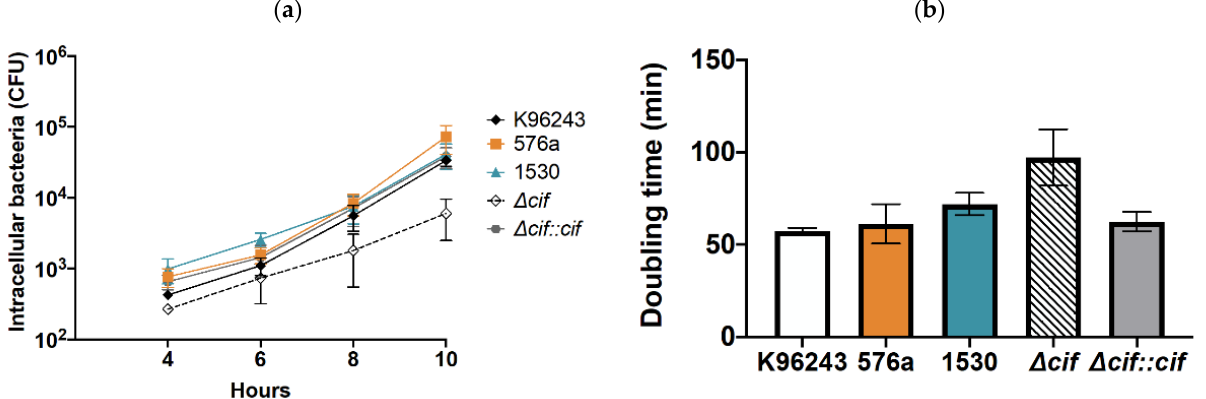
Figure 2. Invasion efficiency of B. pseudomallei strains into SH-SY5Y cells. B. pseudomallei strains infected SH-SY5Y cells at an MOI of 20. At 2 h post-infection, the invading bacteria were harvested and plated on culture plates for enumeration. Values are shown as the mean ± SEM of three independent experiments. ns: not significant, * p < 0.05, ** p < 0.01. ( a ) Invasion of B. pseudomallei K96243, 576a, and 1530. ( b ) Invasion of B. pseudomallei K96243, cif -deleted mutant ( ∆ cif ), and complemented cif mutant strain ( ∆ cif::cif ).